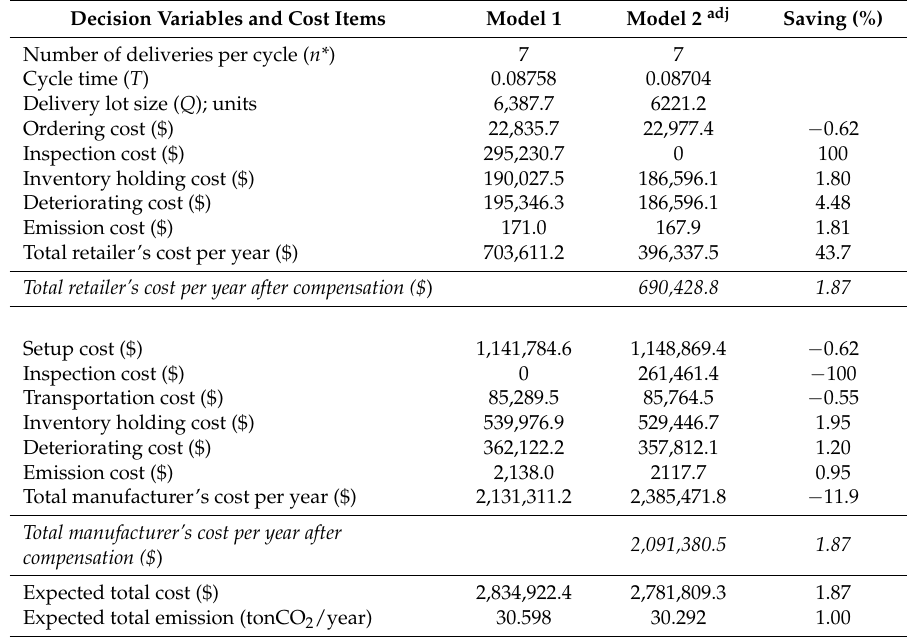
Table 6. Comparison between Model 1 and the adjusted Model